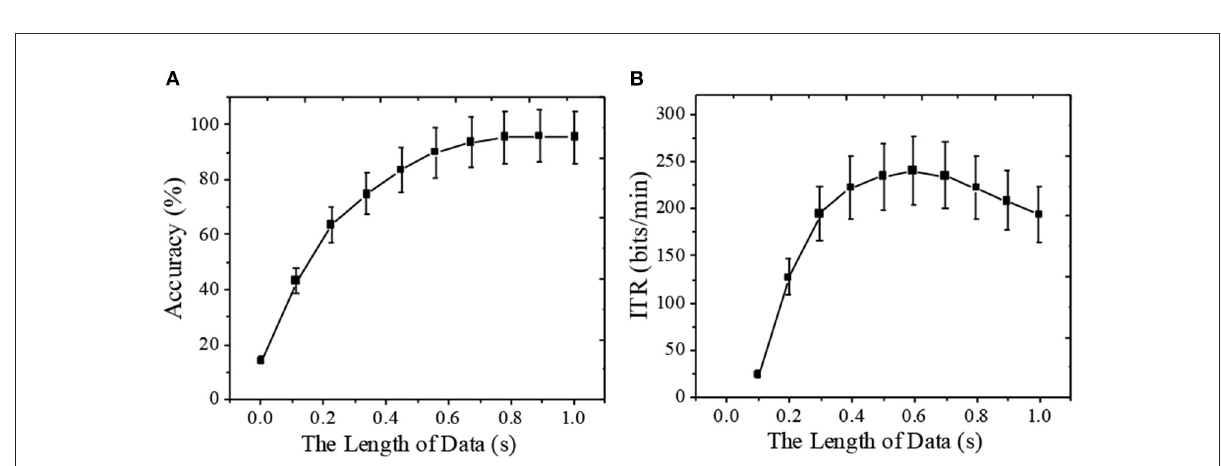
paradigm also increase with the increase of data